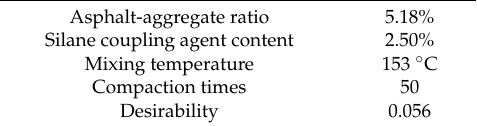
Table 9. Optimal conditions obtained by Numerical optimization.